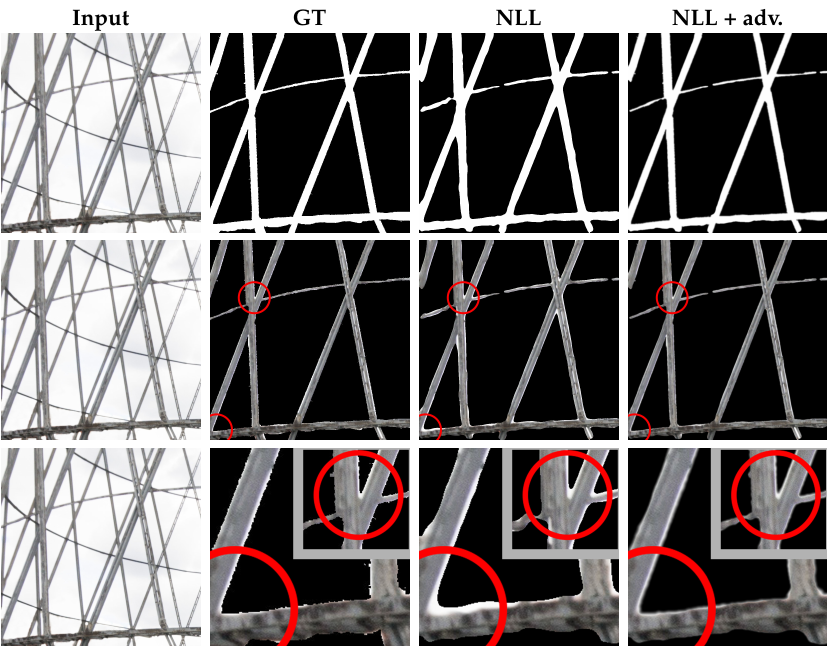
Figure 8. Ablation study of the adversarial loss function: Two versions of the WireNetV2 model are compared: an ablated version without adversarial loss (NLL) and the full version (NLL + adv). Please, note that adversarial loss allows to reduce the amount of background visible through the masks (areas in red